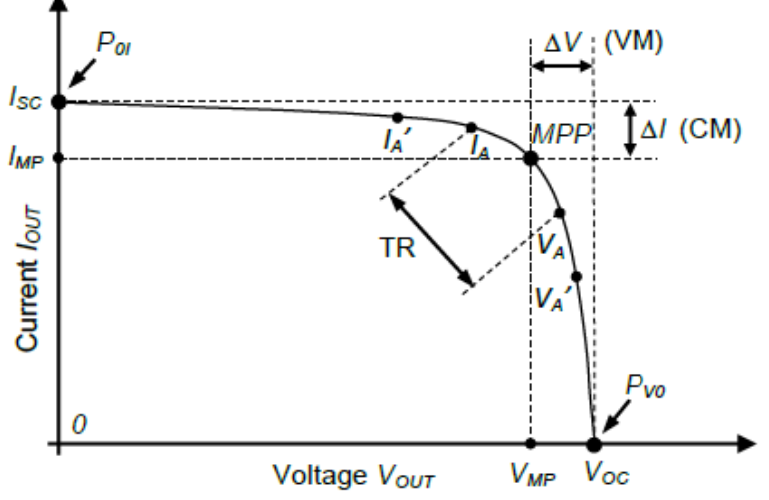
Figure 7. Graphical presentation of the emulation method.